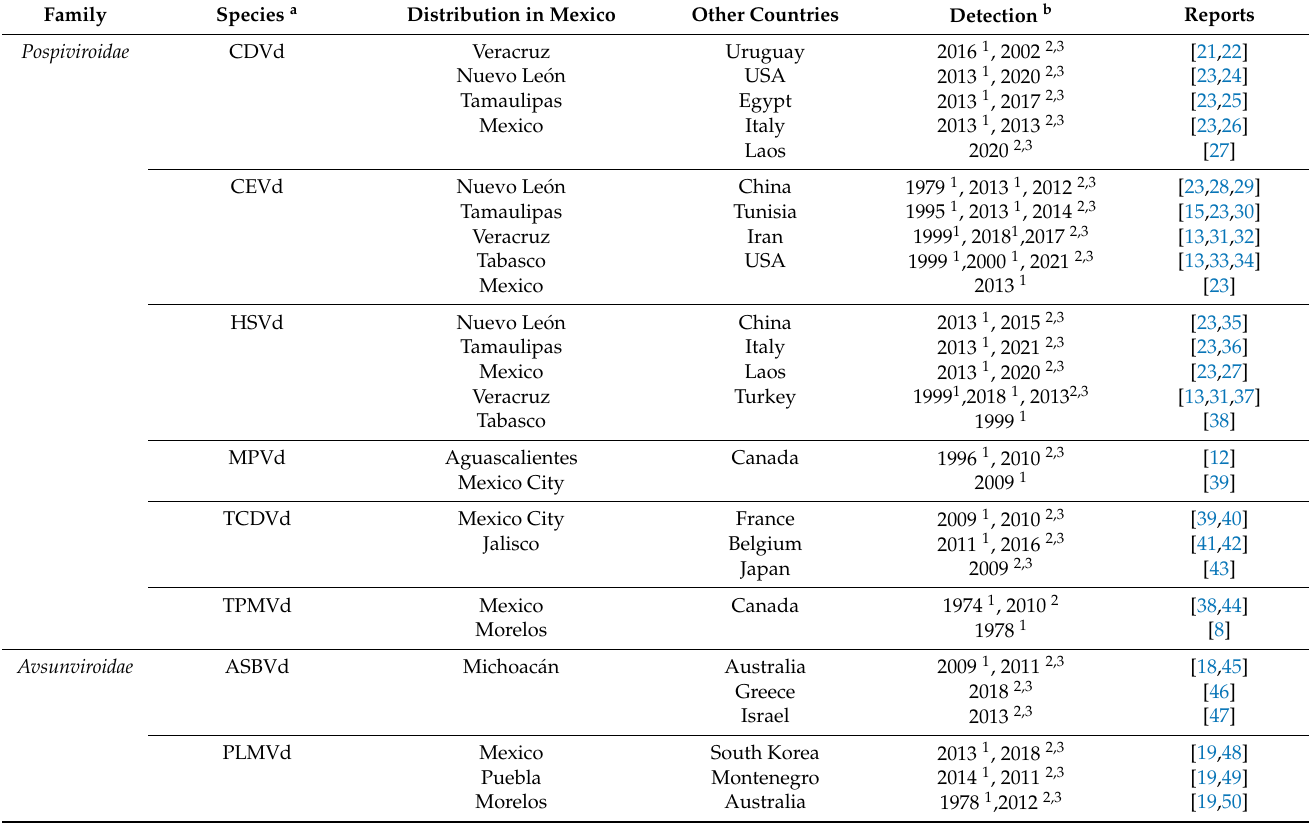
Table 2. Viroids species reported in Mexico and their worldwide